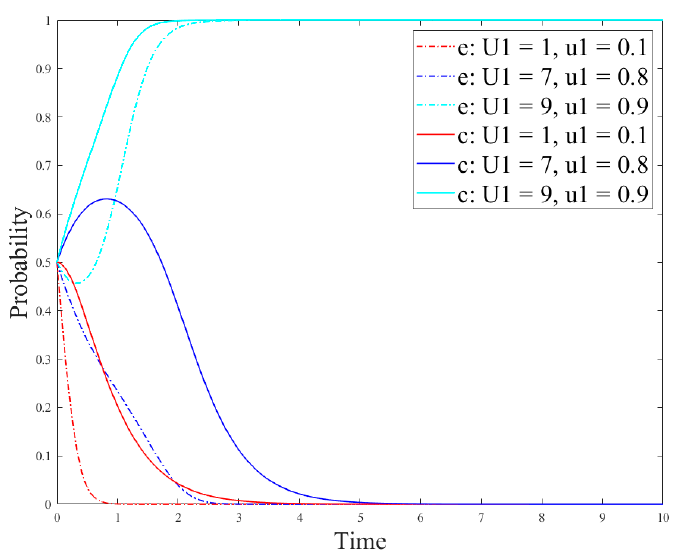
Figure 12. Evolutionresults of the enterprise and consumer strategies ( e : enterprise, c : consumer) ( U 1 :consumer’s utility of using new products; u 1 :degree of positive influence of the online public opinion on the new product on the company.).